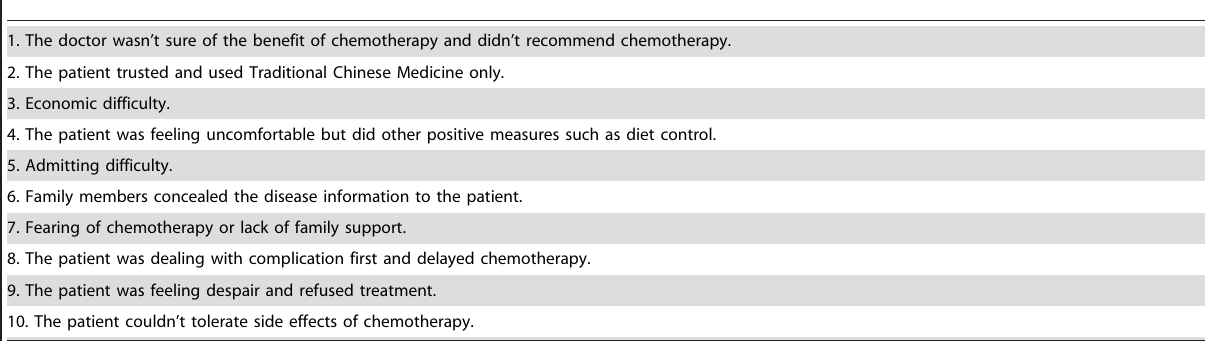
Table 3. The summary of subjective chemo-refusing